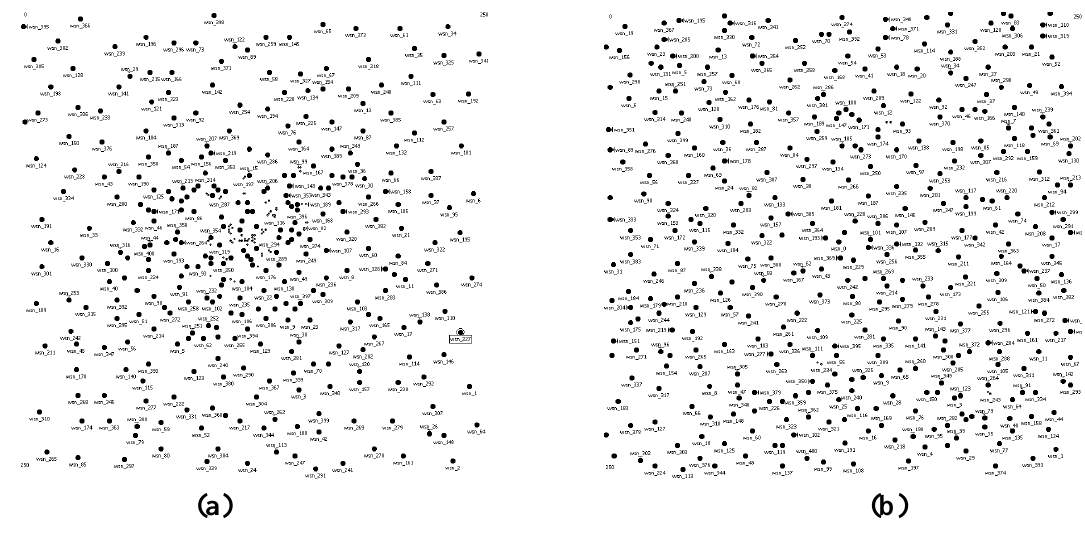
Figure 7. A case of node distribution (N = 400, R = 125 m, r = 40 m, sink is located at